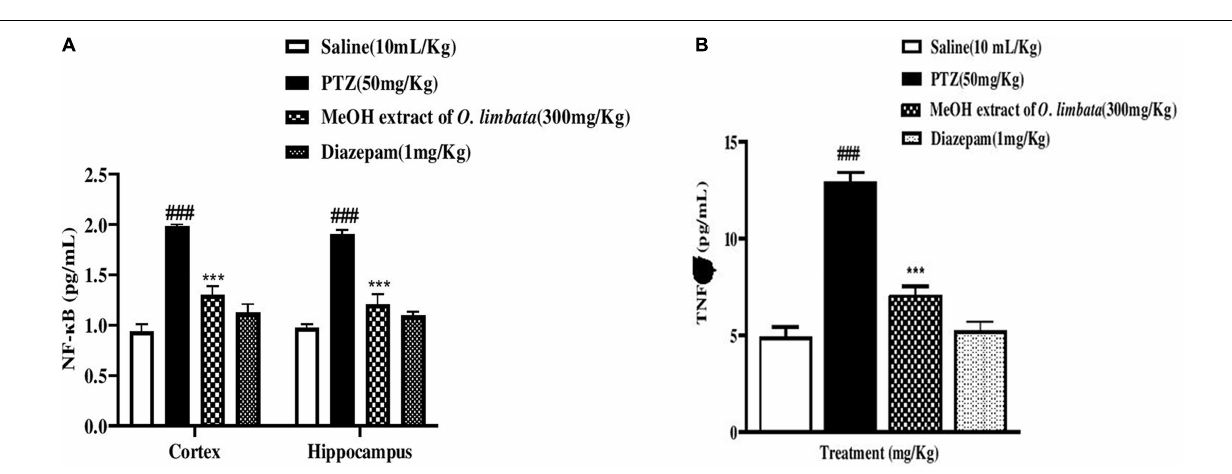
FIGURE 8 | (A) Graphical representation of effect of O. limbata on the downregulated expression of p-NF-kB in the cortex and hippocampus of all treated mice; symbol ### symbolizes the significant difference from saline at P < 0.001, while symbols *** indicate significant difference from PTZ at P < 0.001. (B) Effect of O. limbata on TNF- α expression in the cortex of all treated mice; symbols. ### symbolizes the significant difference from saline at P < 0.001, while symbols *** indicate a significant difference from PTZ at P <